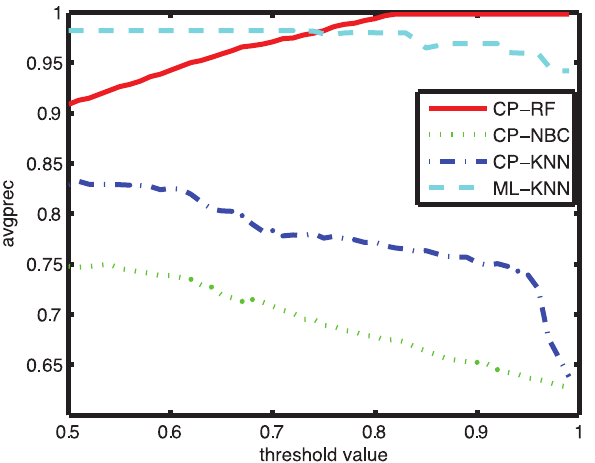
Figure 8. Comparison of average precision with different